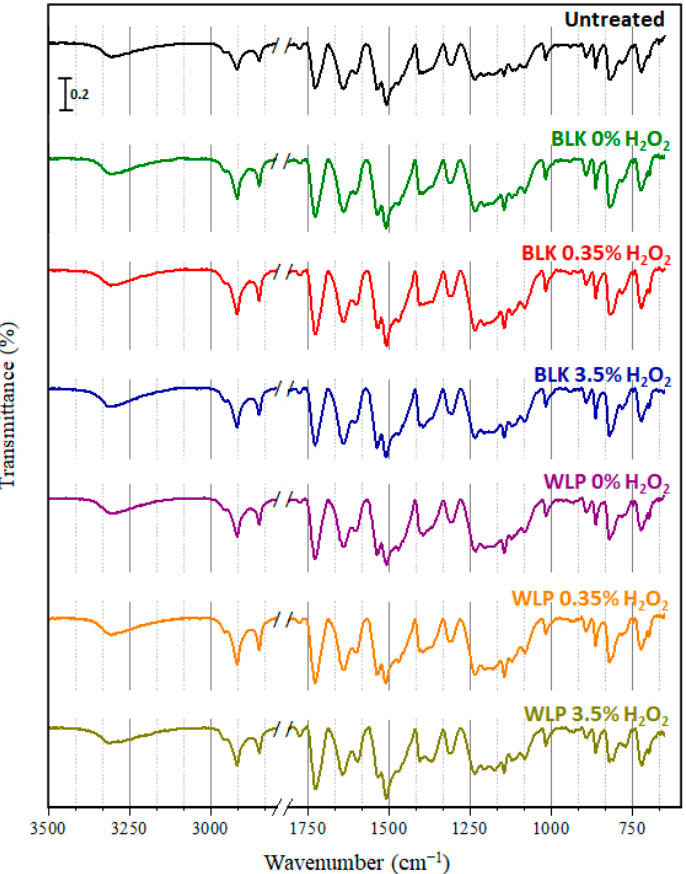
Figure 5. FTIR/RTA spectra of untreated sample and treated samples after exposure for 3 days: BLK 0% of H 2 O 2 , BLK 0.35% of H 2 O 2 , BLK 3.5% of H 2 O 2 , WLP 0% of H 2 O 2 , WLP 0.35% of H 2 O 2 , and WLP 3.5% of H 2 O 2 .